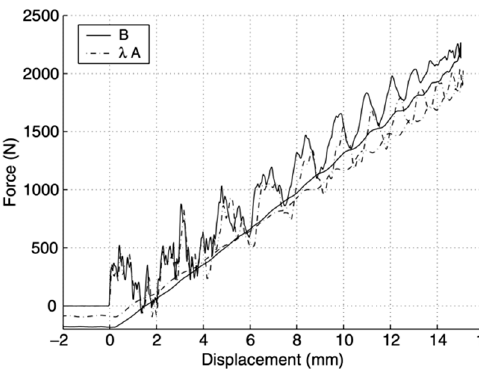
Figure 4. Force–displacement, at speeds of 1.8 and 2.2 m/s [16]. Lower impact speed, for both samples (“ A ” and “ B ”), is very small when compared with the kinetic energy of the initial dart. This is indicative of the fact that the structural damage caused is extremely small. As regards the second experimental test carried out on sample “ B ”, the impact at the lowest speed, there are no substantial differences with the test on sample “ A ”, since the increase in the contact force proportional to the trend of the impact energy. The difference lies in reaching the maximum value of the peak force, which as expected is higher for sample “ B ” (2265 N).